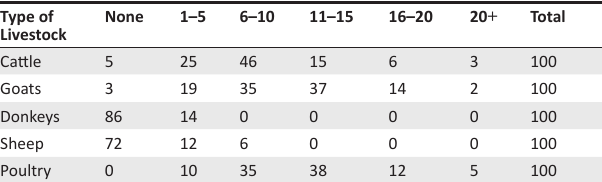
TABLE 3: Household livestock ownership in Chadereka Ward 1 ( %